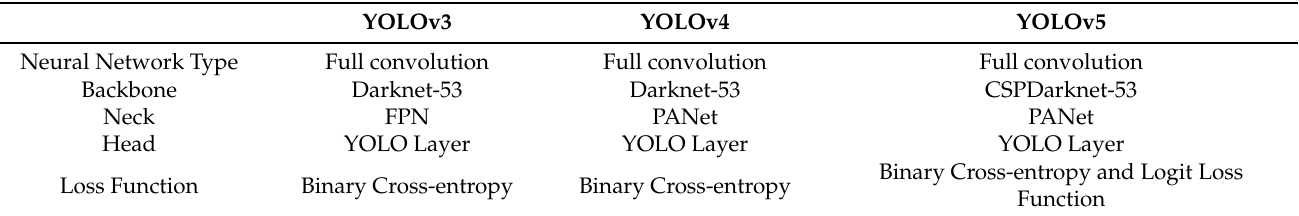
Table 1. Comparison between different YOLO architectures